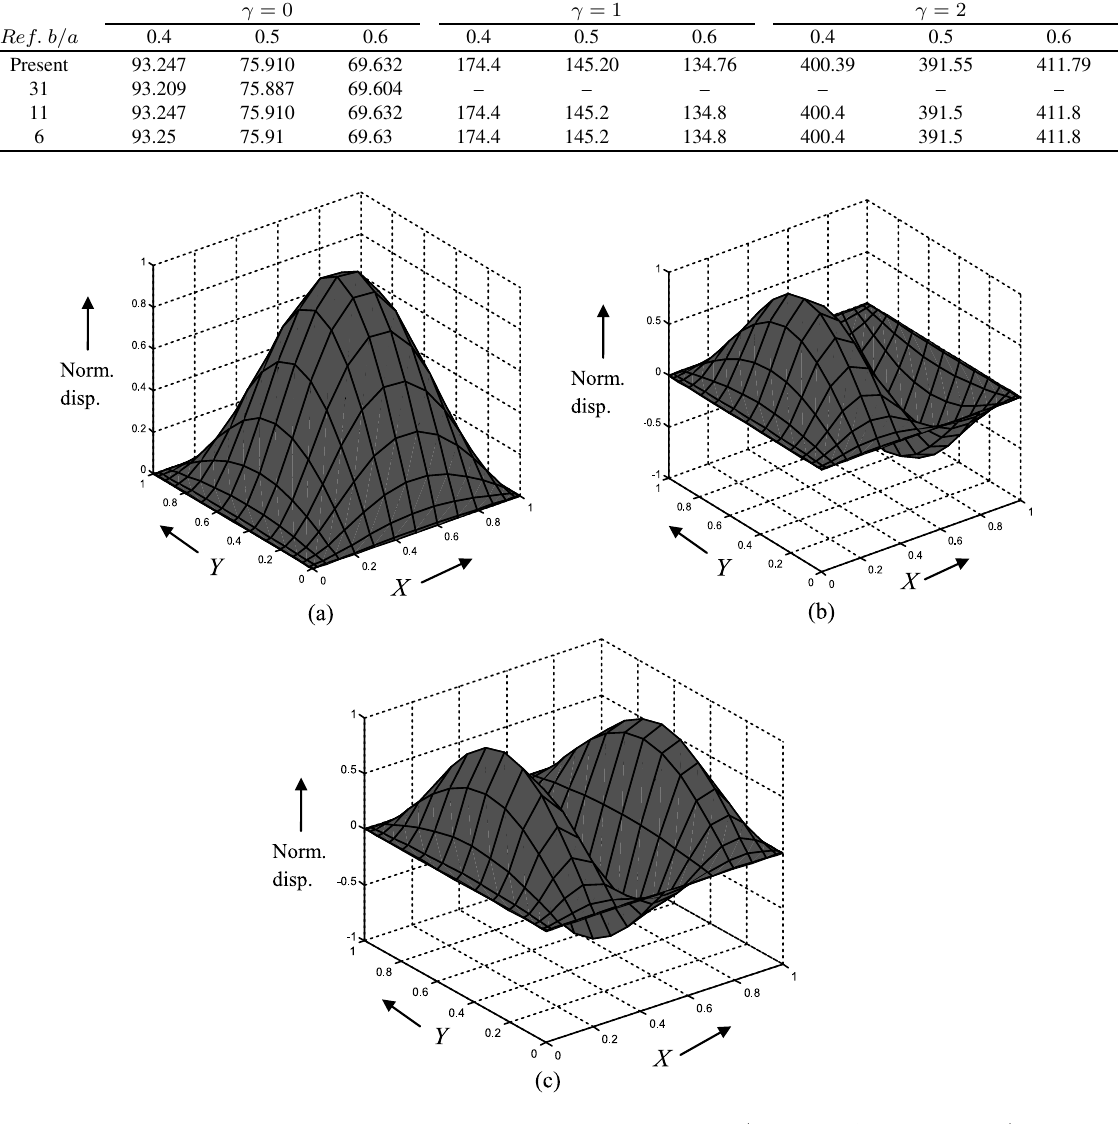
Fig. 11. Vibration modes of C-S plate (a) first mode (b) second mode (c) third mode; for a/b = 1 ,μ = β = 0 . 5 ,γ = 1 ,N ∗ 0 = 30 . loads N ∗ cr for homogeneous ( μ = 0 , β = 0 ) C-C plate for the values of loading parameter γ = 0 , 1 , 2 , aspect ratio b/a = 0 . 4 , 0 . 5 , 0 . 6 and p = 1 with Lal and Dhanpati [31] obtained by quintic spline technique,